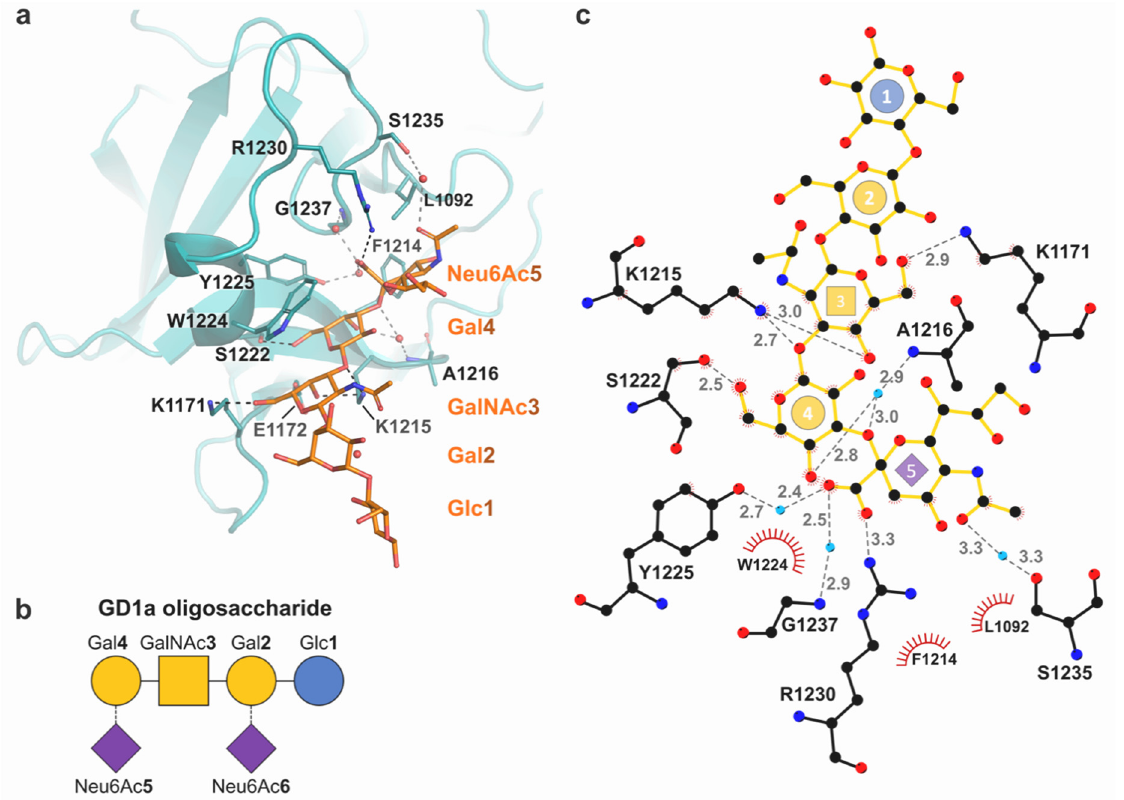
Figure 2. Mechanism of carbohydrate recognition ( a ) Structure of H C /E (teal) in complex with the GD1a-oligosaccharide (orange). Molecular interactions are shown with hydrogen bonds and water-mediated contacts as black and grey dashes, respectively, and water molecules as red spheres. ( b ) Glycoblock schematic representation [29] of the GD1a carbohydrate. ( c ) Schematic of ligand interactions (produced with LigPlot+ [30] ). Electrostatic bonds are shown in grey dashes with distance in Å. Residues involved in hydrophobic interactions are represented by red arcs.